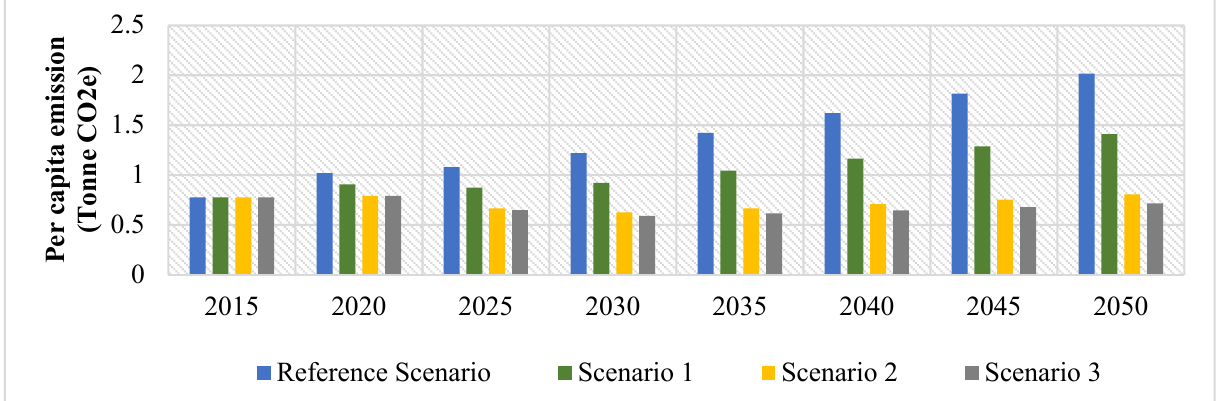
Figure 4. Per capita emissions under different scenarios.